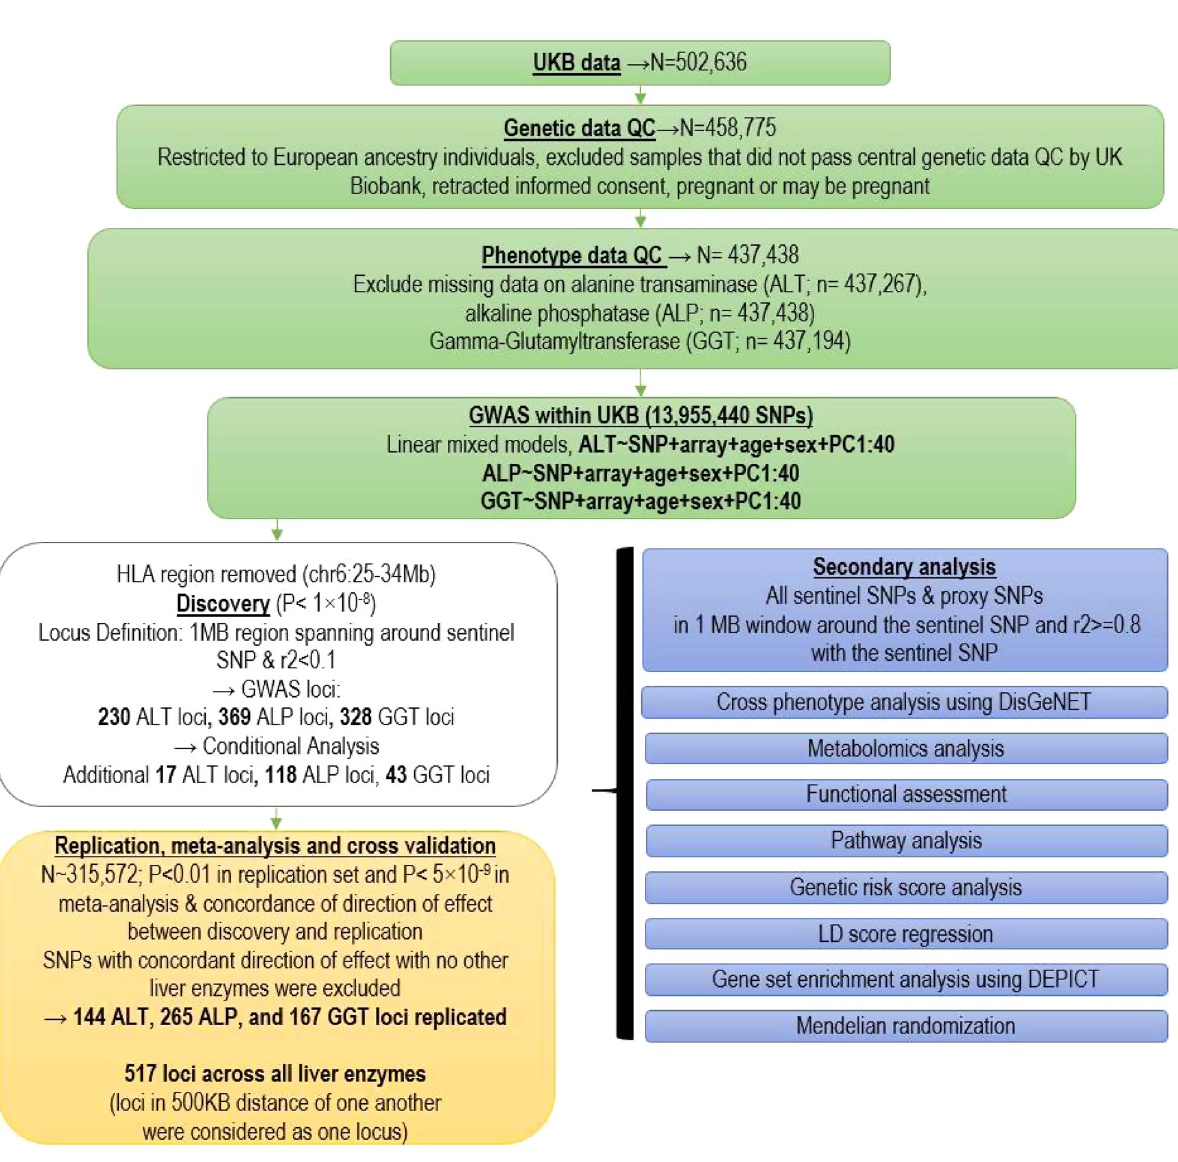
Fig. 1 Overview of study design and fi ndings. The fi gure illustrates the genotype and phenotype quality control (QC) within the UK Biobank (UKB) data. Statistical analysis and replication resulted in 517 loci associated with liver enzymes. PC principal component, SNP single-nucleotide polymorphism, GWAS-genome-wide association studies, LD